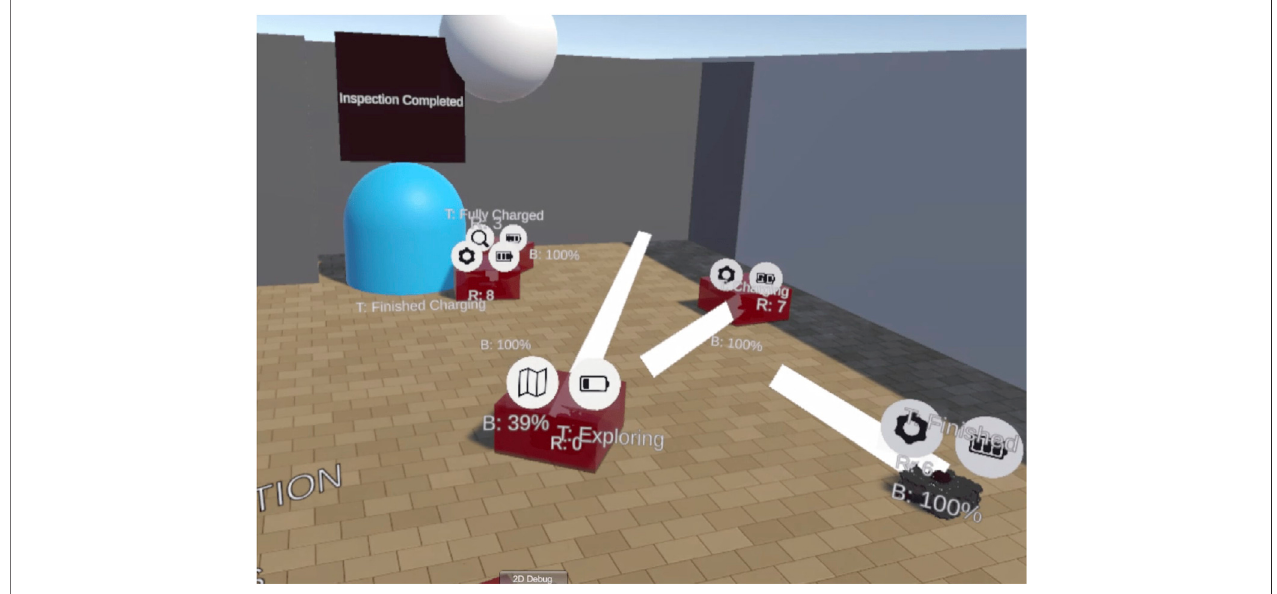
FIGURE 1 | A representative example of the interface. Three layers of information can be seen here: internal text labels (e.g. task status), banner icons (robot category, battery level) and path plans (white lines representing the planned motion of the robot).